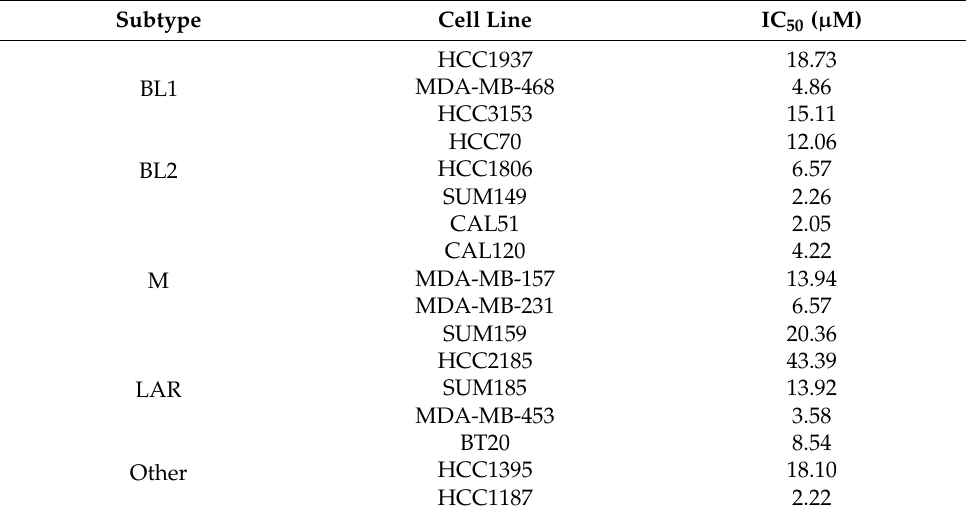
Table 1. The IC 50 s of ONC201 in TNBC cell lines according to subtype (2011 Vanderbilt classification). TNBC cells had varying degrees of sensitivity to ONC201. We did not observe any correlations of TNBC subtype with ONC201 IC 50 . BL1: Basal-like 1, BL2: Basal-like 2, M: Mesenchymal, LAR: Luminal androgen